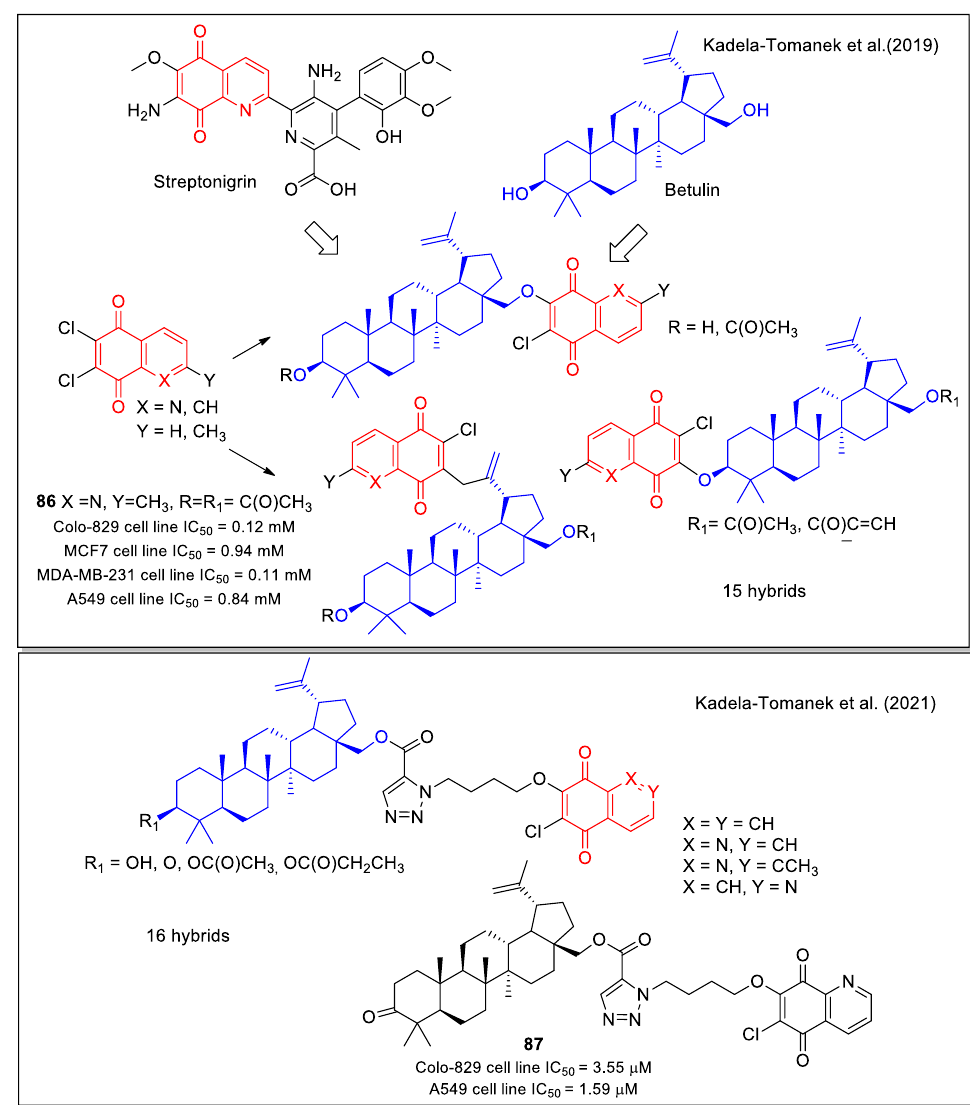
Figure 32. 1,4-Naphthoquinone, quinoline 5,8-dione and isoquinoline-5,8-dione scaffolds in hybrids with betulin as reported by Kadela-Tomanek et al. [73 – 75].